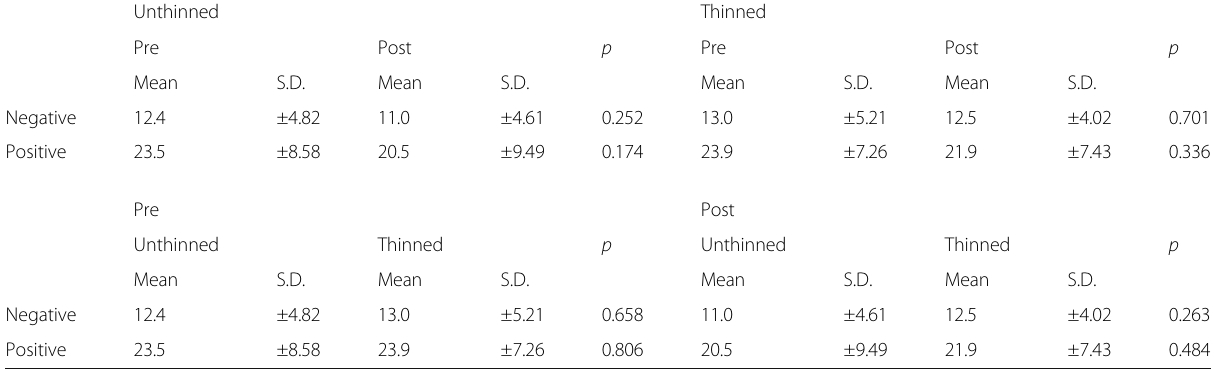
Table 10 Results of multiple comparison tests between before and after thinning (setting) and pre – post (exposure to the forest) for Positive and Negative Affect Scale